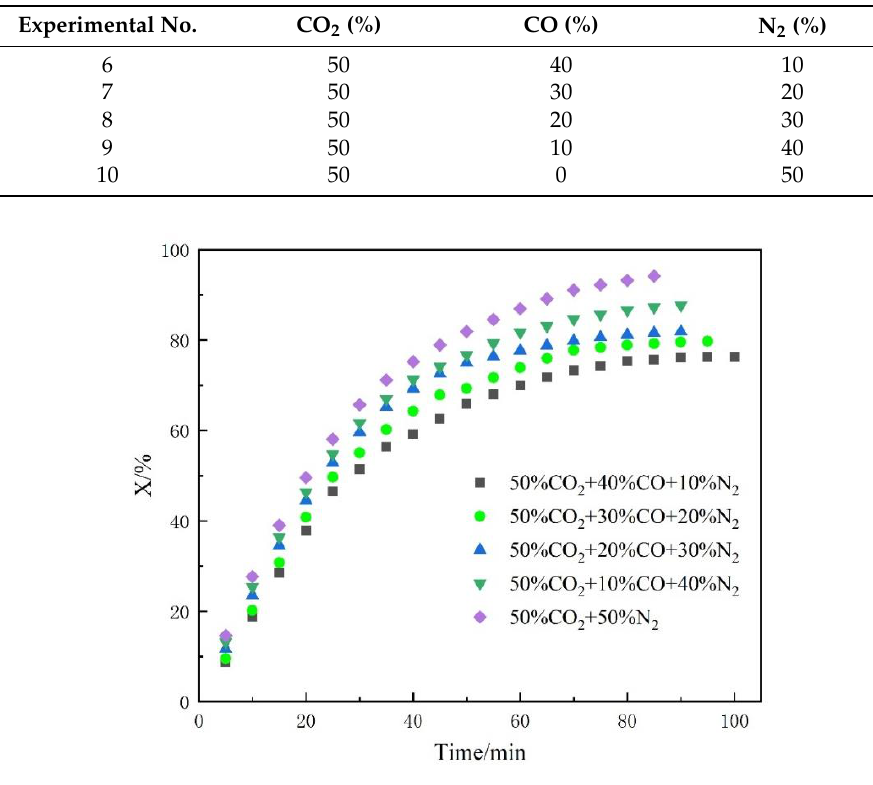
Figure 7. Carbon conversion degree curves of bituminous coal char at 1273 K in the mixture of CO 2 , CO and N 2 .